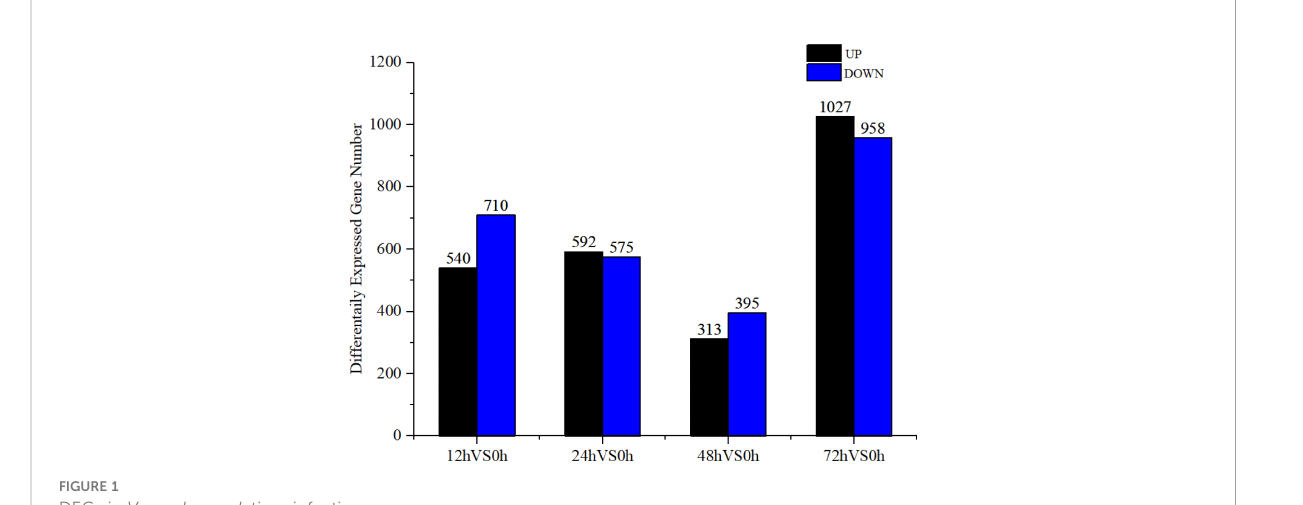
FIGURE 1 DEGs in V. parahaemolyticus infection